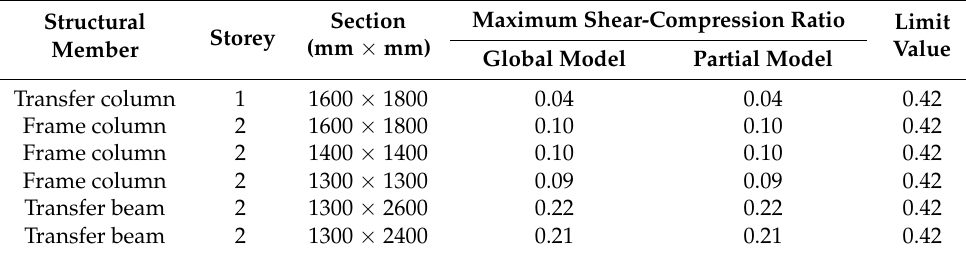
Table 13. Maximum shear-compression ratios of the transfer columns and beams.